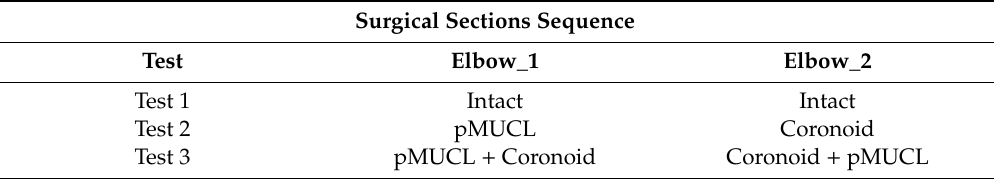
Table 1. List of sequences of surgical section for Elbow_1 and